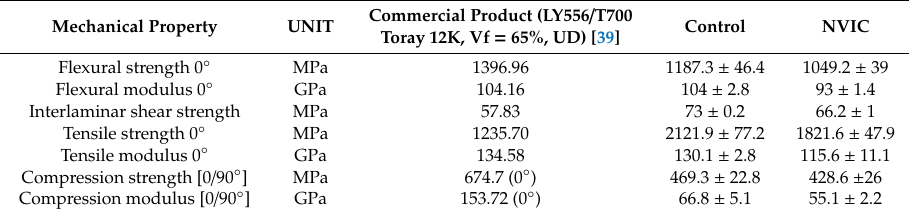
Table 8. In-plane mechanical properties of test specimens and a commercial product.